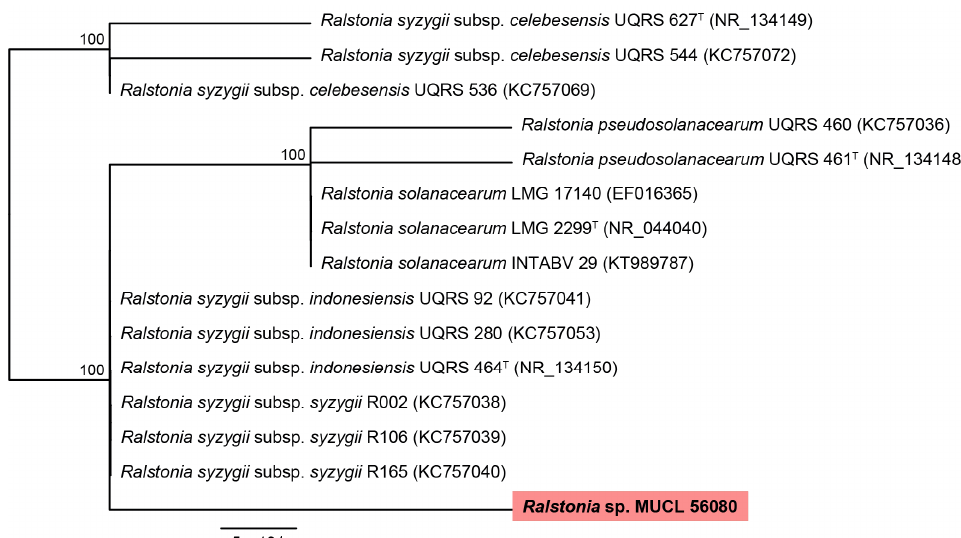
Figure 2. RAxML phylogram obtained from 16S sequences of taxa included in Ralstonia solanacearum species complex. Bootstrap support values ≥ 70 are indicated along branches. Branch lengths are proportional to distance. Ex-type strains are indicated with T . The maximum-likelihood (ML) analyses employed RAxML on the CIPRES portal (www.phylo.org, accessed on 12 May 2022) using RAxML-HPC BlackBox v8.2.12 with default parameters. Our strain studied is highlighted using pink colour.